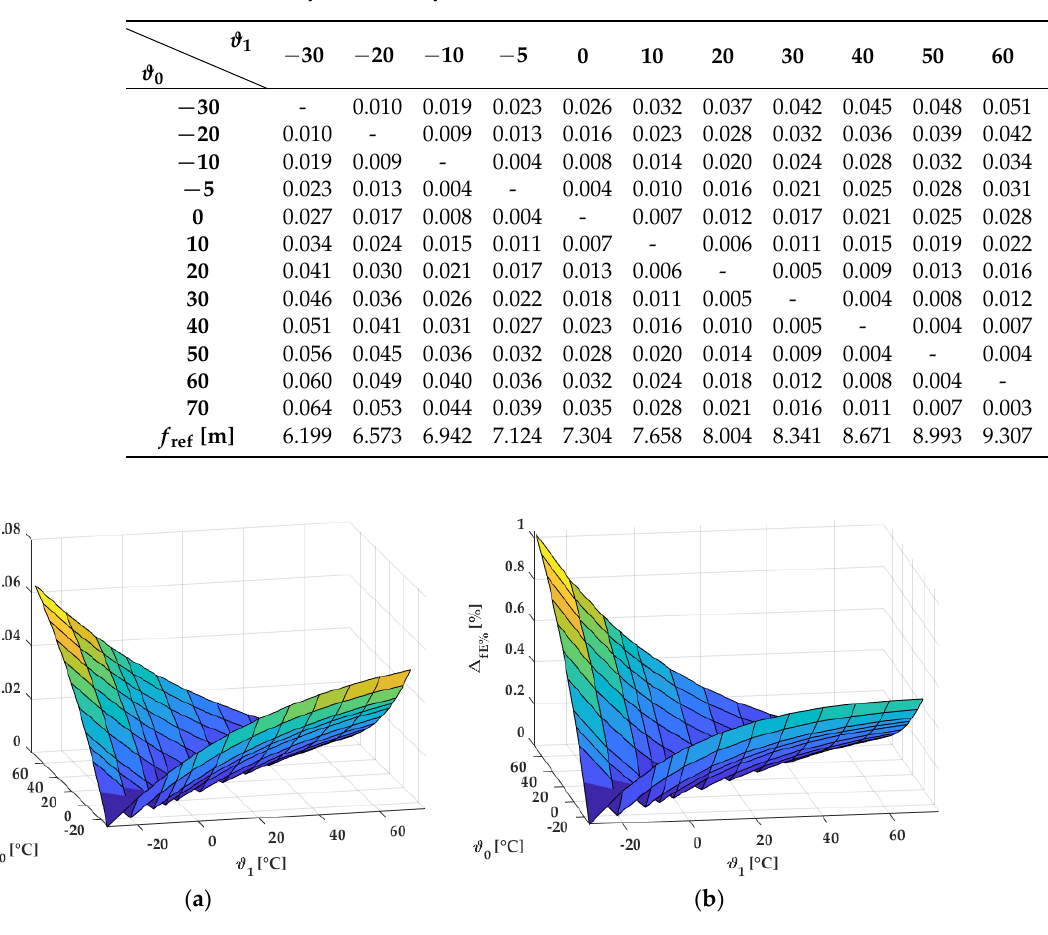
Figure 12. The dependence of sag deviations caused by the incorrect determination of the conductor elasticity modulus by ± 10%: ( a ) Absolute sag deviations; ( b ) percentage sag